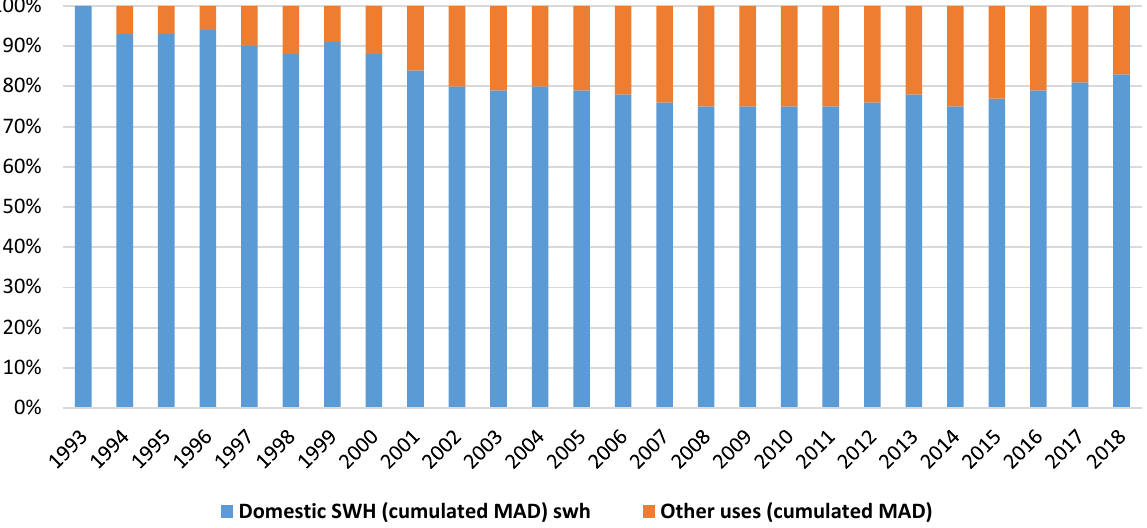
Figure 6. Domestic solar water heaters sales in Morocco.